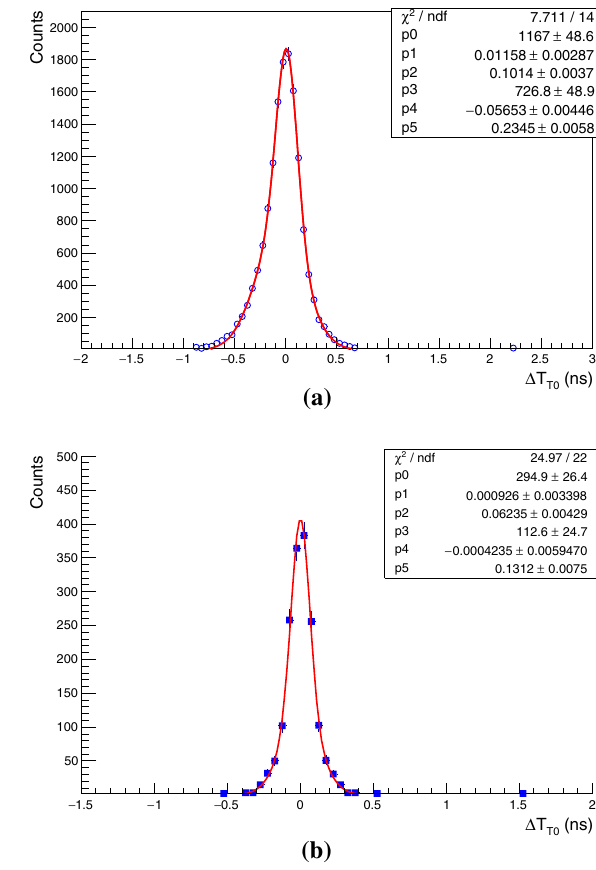
Fig. 22 Typical start time difference between two T0 groups vs. effec- tive particle velocity Fig. 23 Start time difference between two T0 groups (top), and within one T0 group